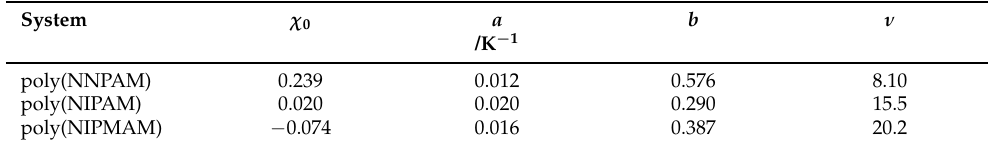
Table 2. Parameters of the homopolymers determined from our previous work [35]. The parameters χ 0 , a and b are independent of the cross-linker N,N’ -methylenebisacrylamide (BIS) and initiator ammonium persulfate (APS) concentration but ν is dependent on the BIS concentration. For all syntheses, a BIS concentration of 10 mol% was used therefore ν at 10 mol% BIS from the previous work is listed here. ν nicely follows the hydrophilicity difference of the three systems with poly(NIPMAM) being the most